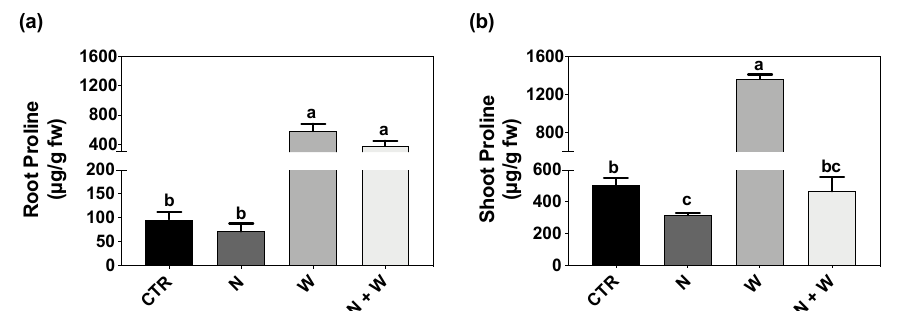
ments did not differ from each other (Figure 3b). tions (Figure 2b).